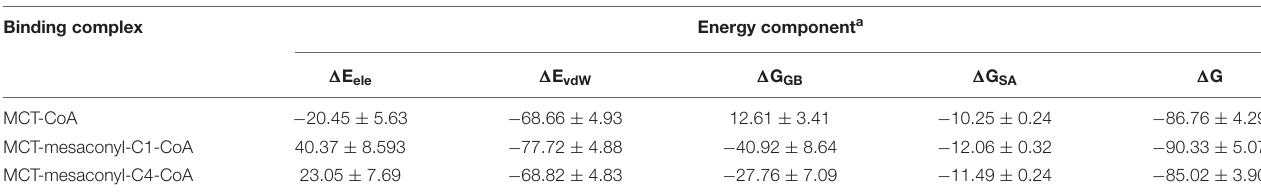
FIGURE 4 | Conformational changes of the substrate binding pocket in binding with different CoA analogs. (A) Superimpositions of the amino acid residues that are necessary for coordinating the CoA (green), mesaconyl-C1-CoA (salmon), and mesaconyl-C4-CoA (blue). (B) Superimpositions of the amino acid residues that are necessary for coordinating mesaconyl-C1-CoA (salmon) and mesaconyl-C4-CoA (blue) with the apo-MCT (white). (C,D) The binding mode of mesaconyl-C1-CoA (C) , mesaconyl-C4-CoA (D) , and the surface electrostatic potentials of MCT that are represented with positive, negative, and neutral charged residues colored in blue, red, and white, respectively. The key amino acid residues for coordinating the CoA analogs are shown in stick models. TABLE 3 | Binding free energies calculated using the MM/PBSA